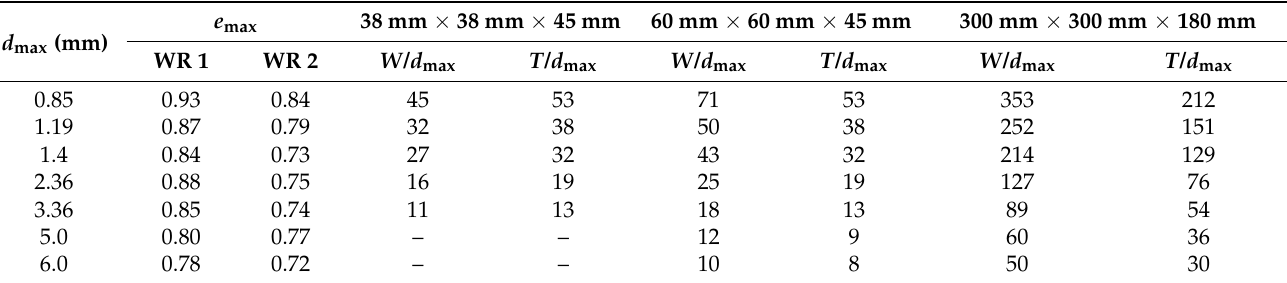
Table 10. Shear boxes and specimen size to d max ratios, used in the direct shear tests on the two types of waste